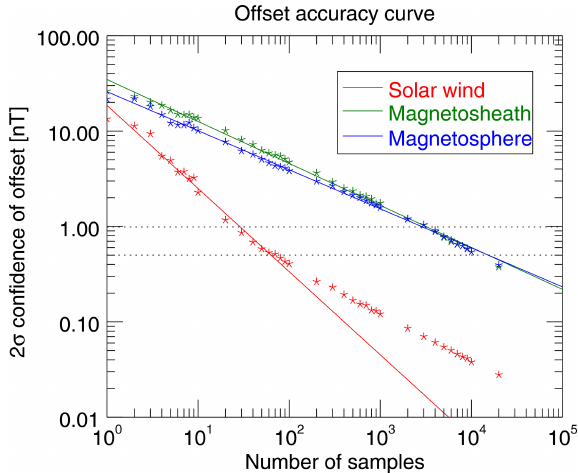
Figure 3. Probability density function P , estimated with the KDE method from Eq. (3) from 4 years of MESSENGER observations.